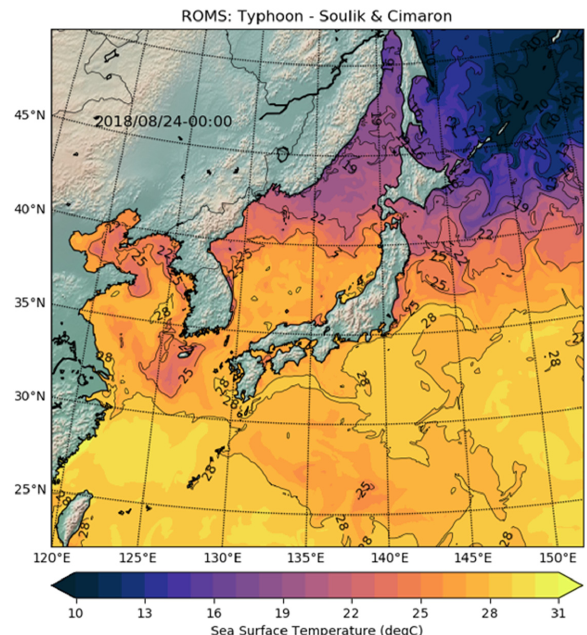
Figure 13. Real experimental results using ROMS during the period of typhoons Soulik and Cimaron: colors = SST, arrows = sea surface currents.